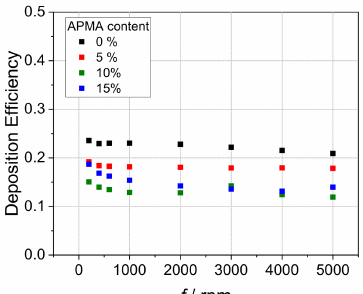
Figure 3. Deposition efficiencies vs. rotation rate f in hydrodynamic voltammograms of 0.13 mM HCF(II) in 0.1 M KCl in presence of 0.52 mM (with respect to quaternized monomer units, icr = 1) for P(MAPTAC- co -APMA-x%) with 0% (black square), 5% (red square), 10% (green square) and 15% (blue square) APMA